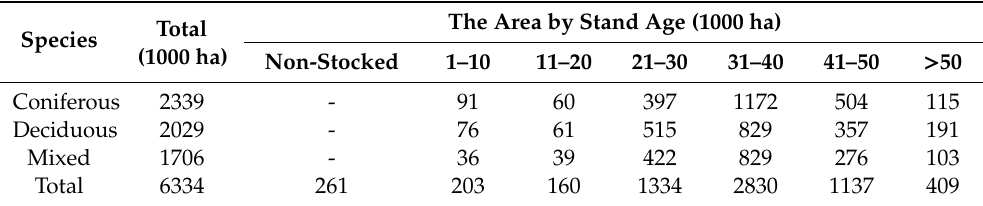
Table 1. Tree species composition of South Korea’s forests [9].